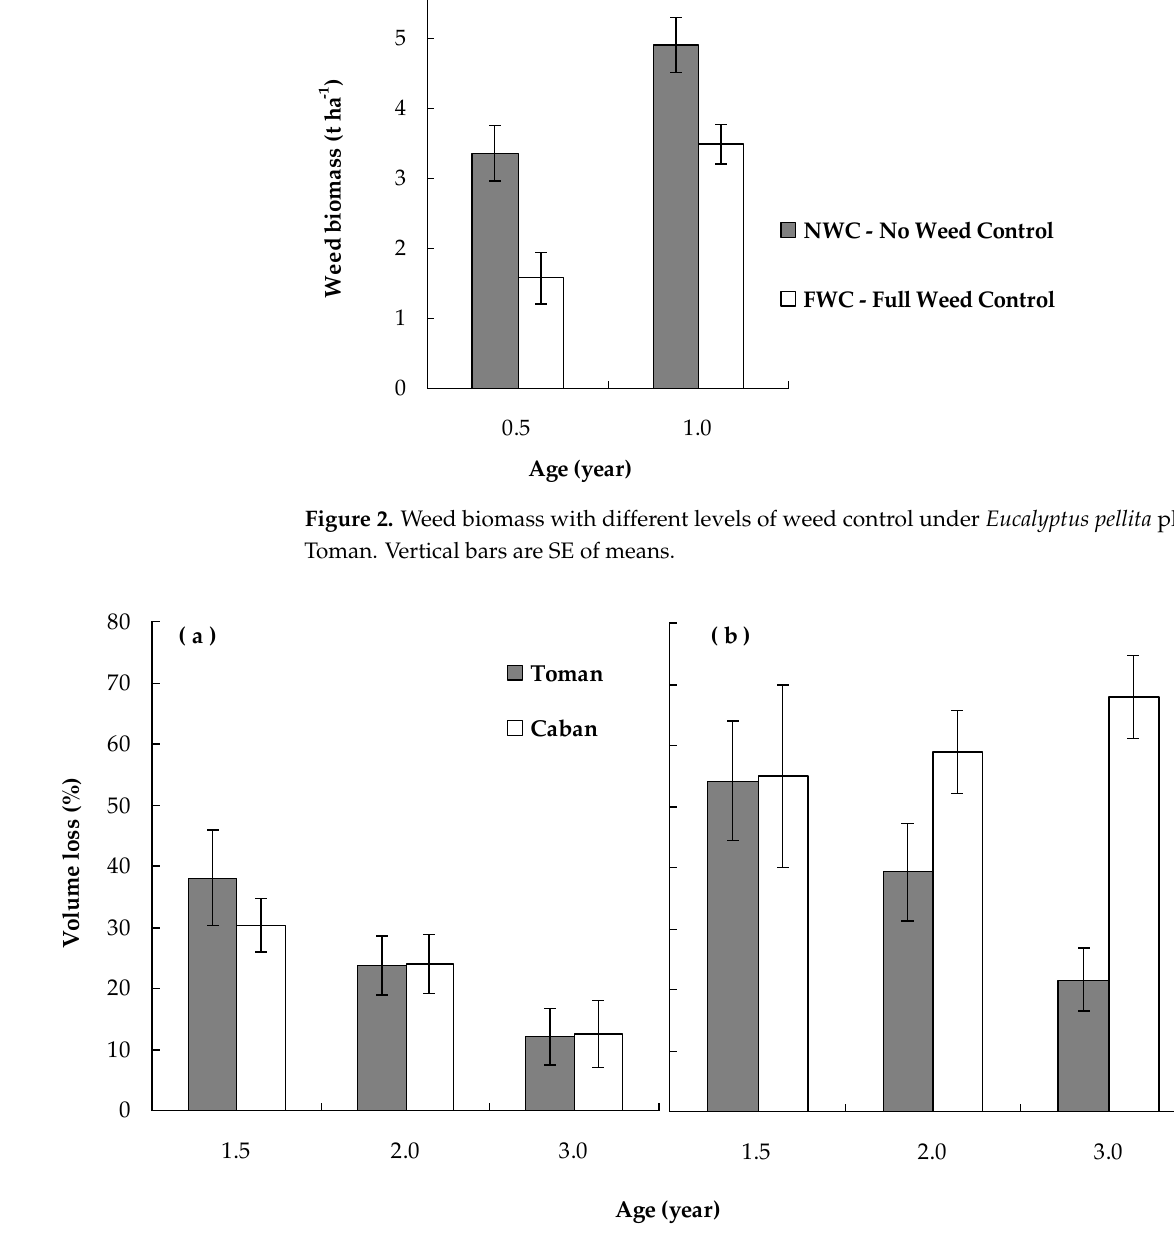
Figure 3. Volume loss in E. pellita due to ( a ) less-intensive weed control (MWC) compared with more-intensive weed control (FWC); ( b ) no weed control (NWC) compared with more-intensive weed control (FWC) at Toman and Caban. Vertical bars are SE of means.